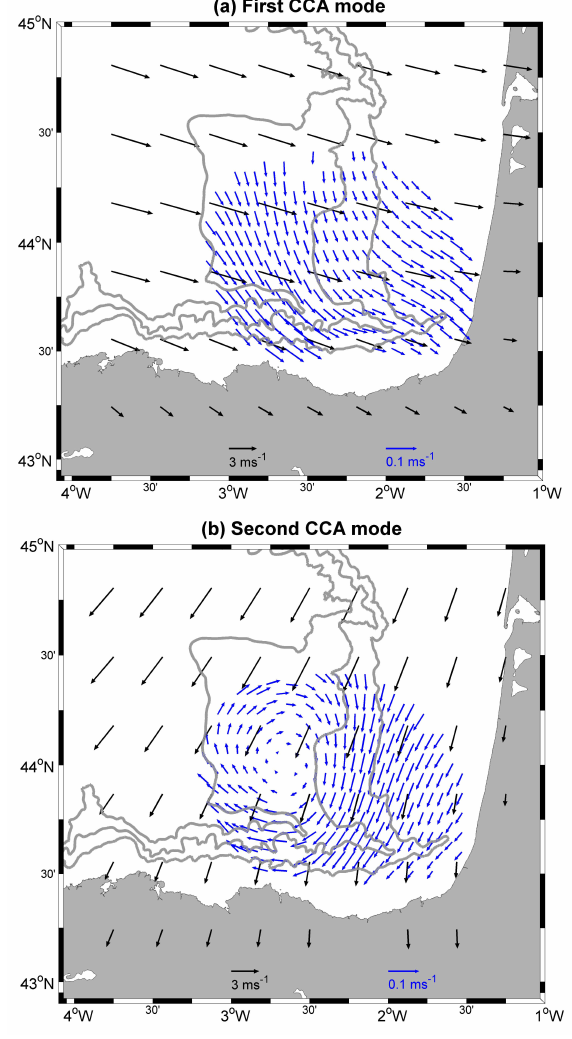
Fig. 5. Maps of homogeneous regression coefficients (ms − 1 ) (sta- tistically significant at the 95% confidence level) of the (a) first and (b) second CCA modes for the currents (blue) and winds (black) for the D1 domain. Bathymetric contours show the 200-, 1000- and 2000-m isobaths.